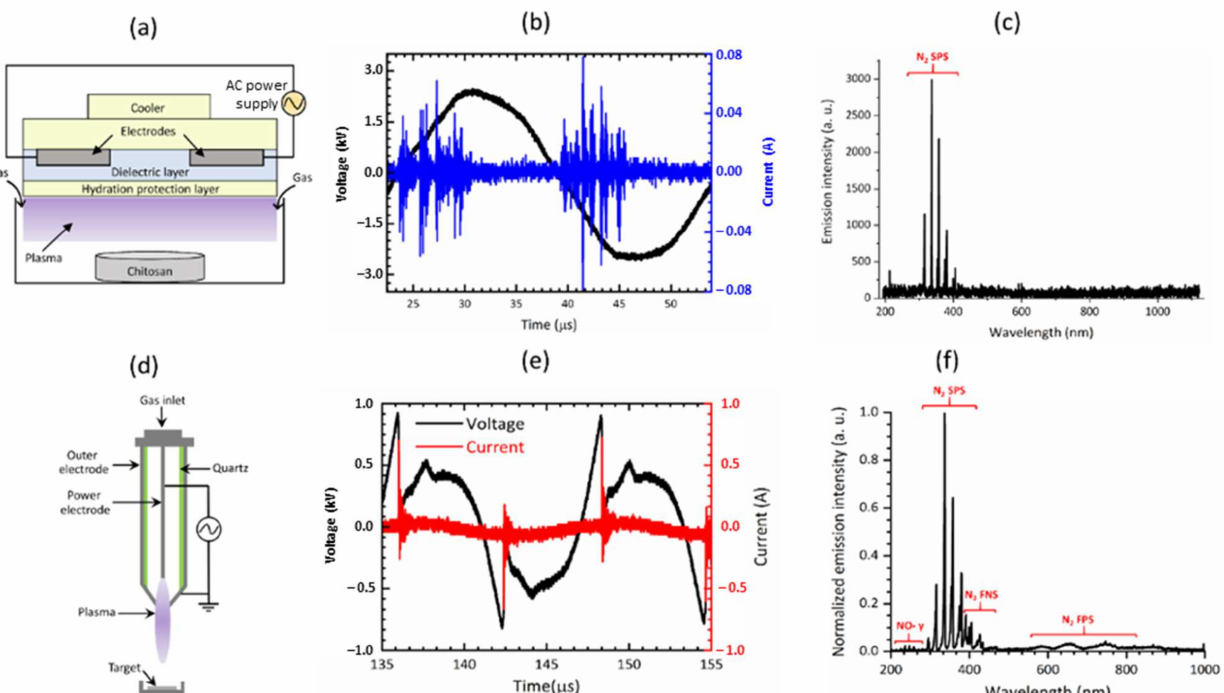
Figure 1. Schematic illustration of the electrical properties of dielectric barrier discharge (DBD) and a soft plasma jet. ( a ) Schematic of DBD, ( b ) current-voltage waveform, and ( c ) optical emission spectrum of DBD. ( d ) Schematic of soft jet, ( e ) current-voltage waveform, and ( f ) optical emission spectrum of the soft plasma